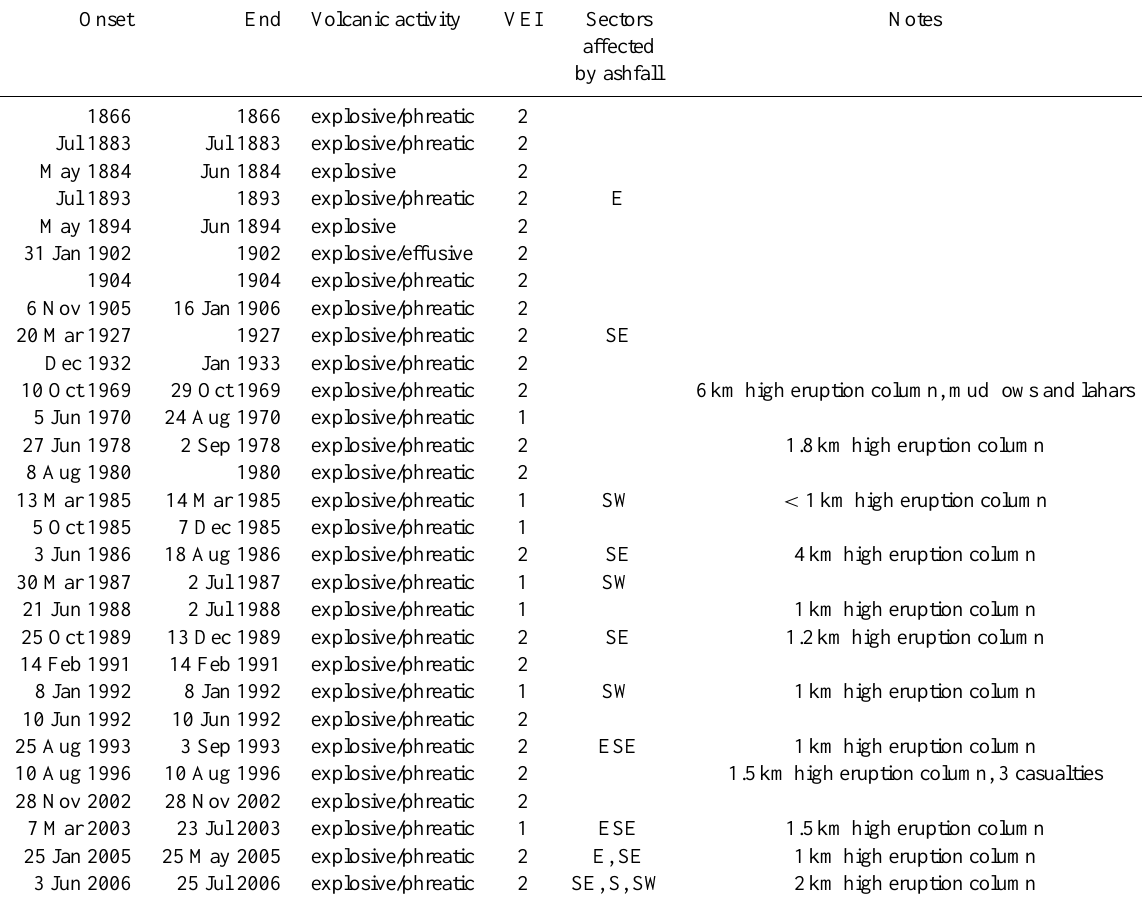
Table 6. Historical eruptive activity of Mt Kanlaon volcano (modified after Siebert et al., 2010, and reports available at http://www.phivolcs.